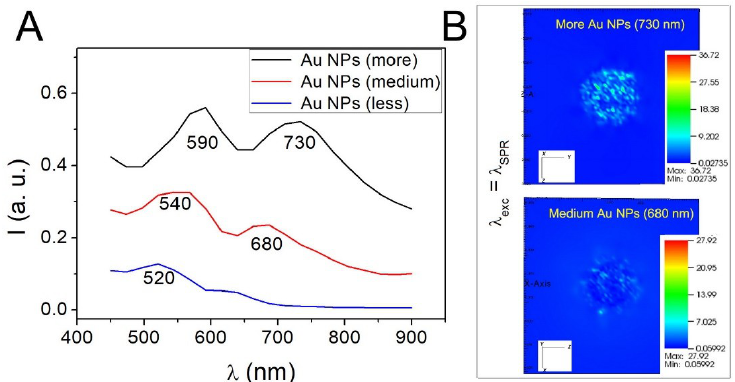
Figure 9. DDA results with dispersed Au NPs in the 5 nm Au shell. ( A ) The wavelength-dependence of extinction and ( B ) the electric field strength (| E |/| E 0 |) of UCNP@mSiO 2 -Au NPs (15 nm–15 nm–5 nm geometry) under the irradiation wavelength λ exc = λ SPR .